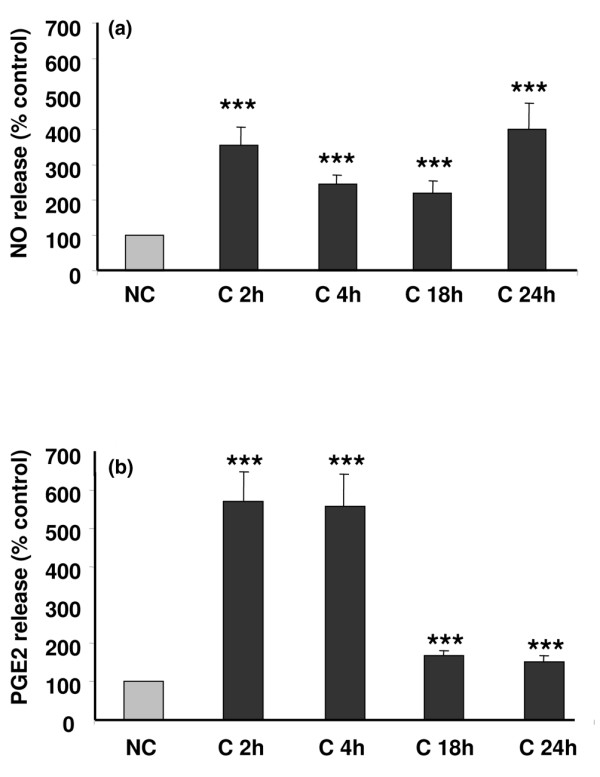
Compression stimulates nitric oxide (NO) and prostaglandin E2 (PGE2) release in mouse costal cartilage explants in the media. Mouse costal cartilage explants were compressed (C) or not (NC) for 2 h, 4 h, 18 h and 24 h. At each time interval, our results are expressed in fold-induction in comparison to the appropriate control. (a) The amount of NO released into the media (μmol/mg of costal cartilage) was measured by Griess reagent. Values are the mean and SEM of 3 (C 2 h and 4 h) and 2 (C 18 h and 24 h) independent experiments with n = 2/group/experiments. ***p < 0.001 versus control (NC). (b) The amount of PGE2 released into the media (pg/mg/ml of costal cartilage) was measured by enzyme immunoassay. Values are the mean and SEM of 3 (C 2 h), 2 (C 4 h and 18 h) and 4 independent experiments (C 24 h) with n = 2/group/experiments, analyzed in duplicate. ***p < 0.001 versus control (NC).